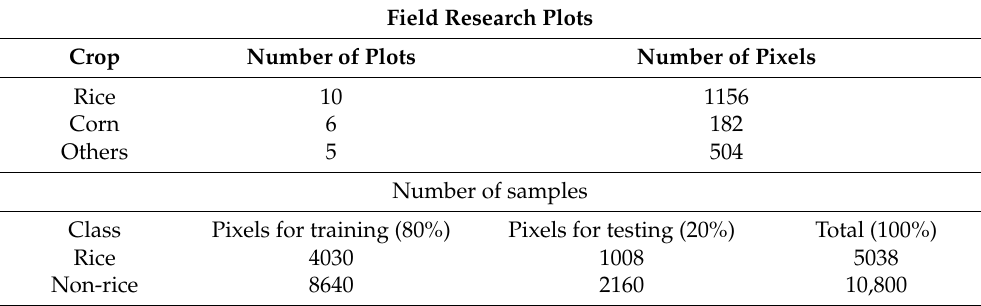
Table 2. Information of the sample set.